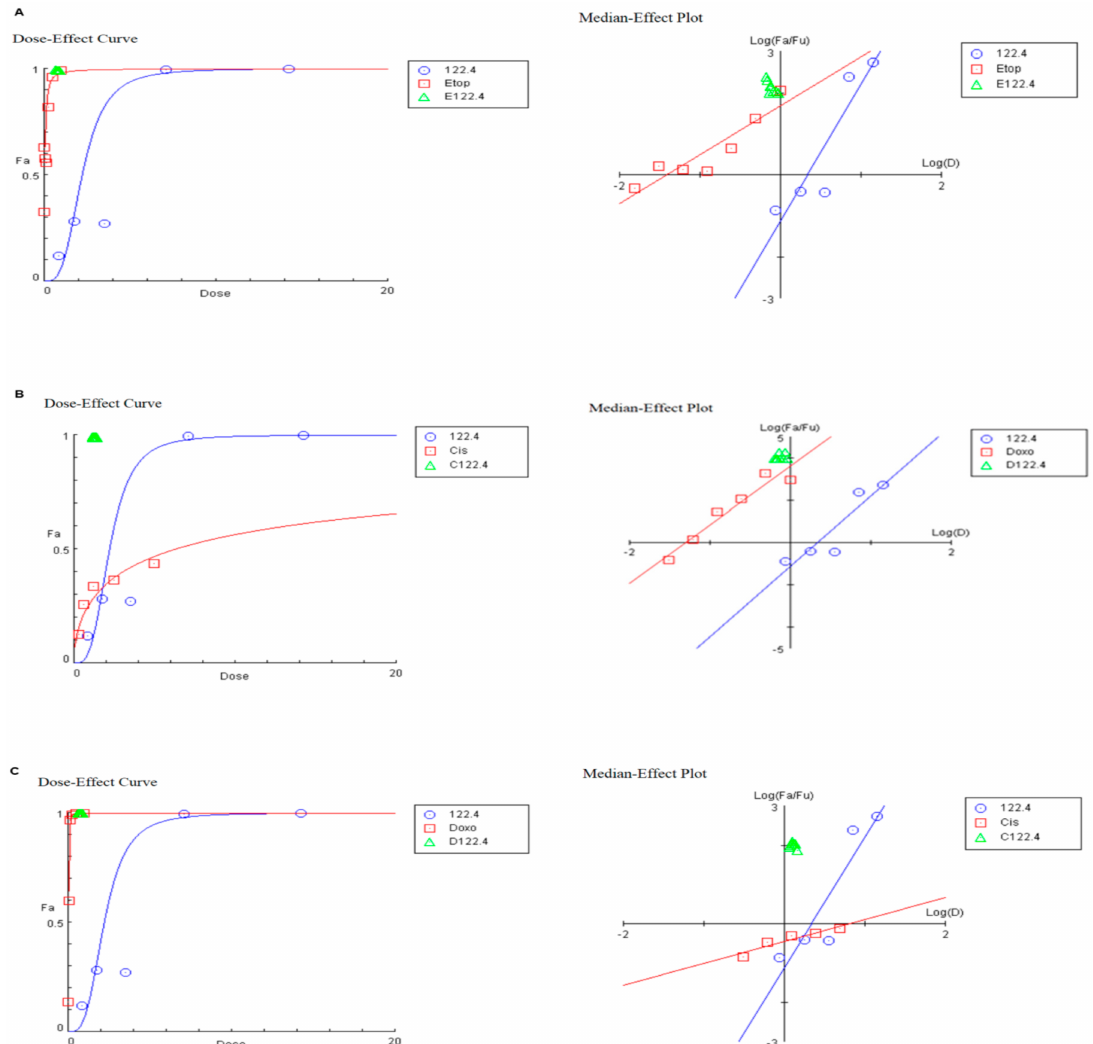
Figure 2. Dose-Effect Curve and its linearization with the Median-Effect Plot for a single and combination treatment of 122.4 and chemotherapy drugs. Right side represents the median-effect plot of single/combination treatment and the left side shows the dose-effect curve of 122.4 with etoposide (Etho), cisplatin (Cis), doxorubicin (Doxo), A – C , respectively. The red line represent chemotherapeutic single treatment, blue line represent the single treatment of 122.4 and green triangle is the combination treatment using ComboSyn (E122.4, C122.4, D122.4 are combinations of 122.4 with etoposide, cisplatin and doxorubicin,